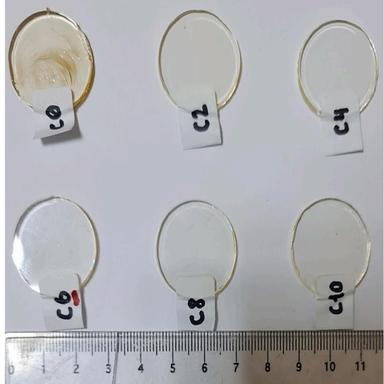
(a–b). Experimental setup for (a) gamma-ray and (b) neutron transmission measurements.